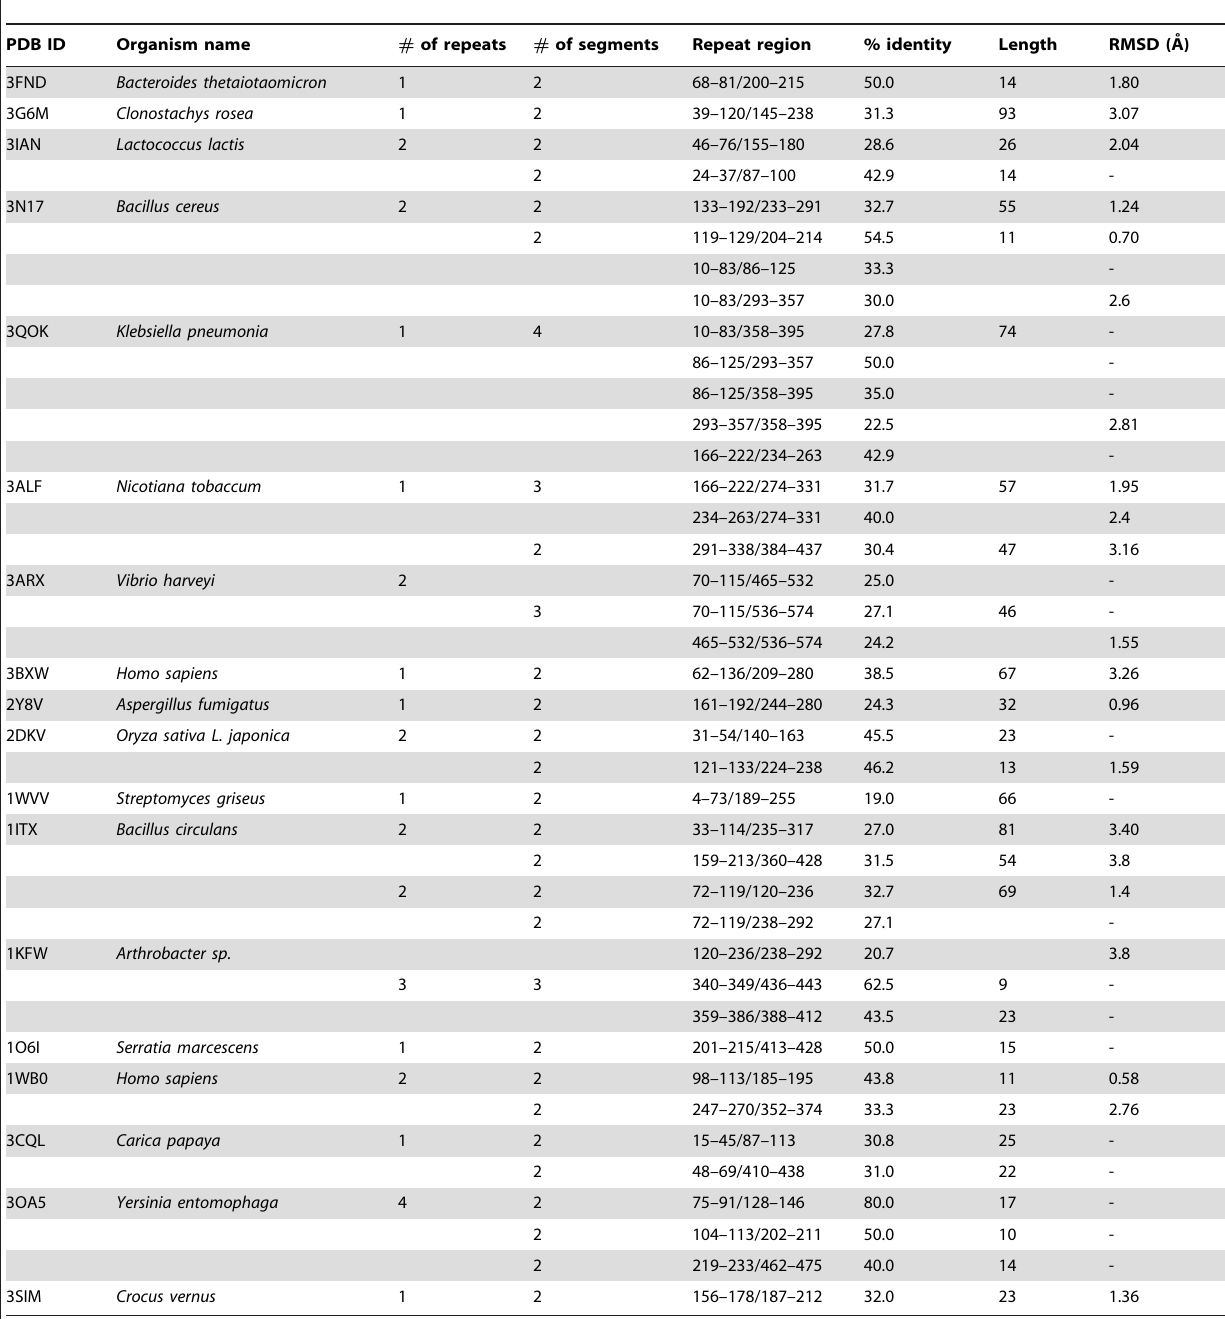
Table 2. List of internal repeats identified in different Chitinase sequences available in the Protein Data Bank with % identity between the repeats and